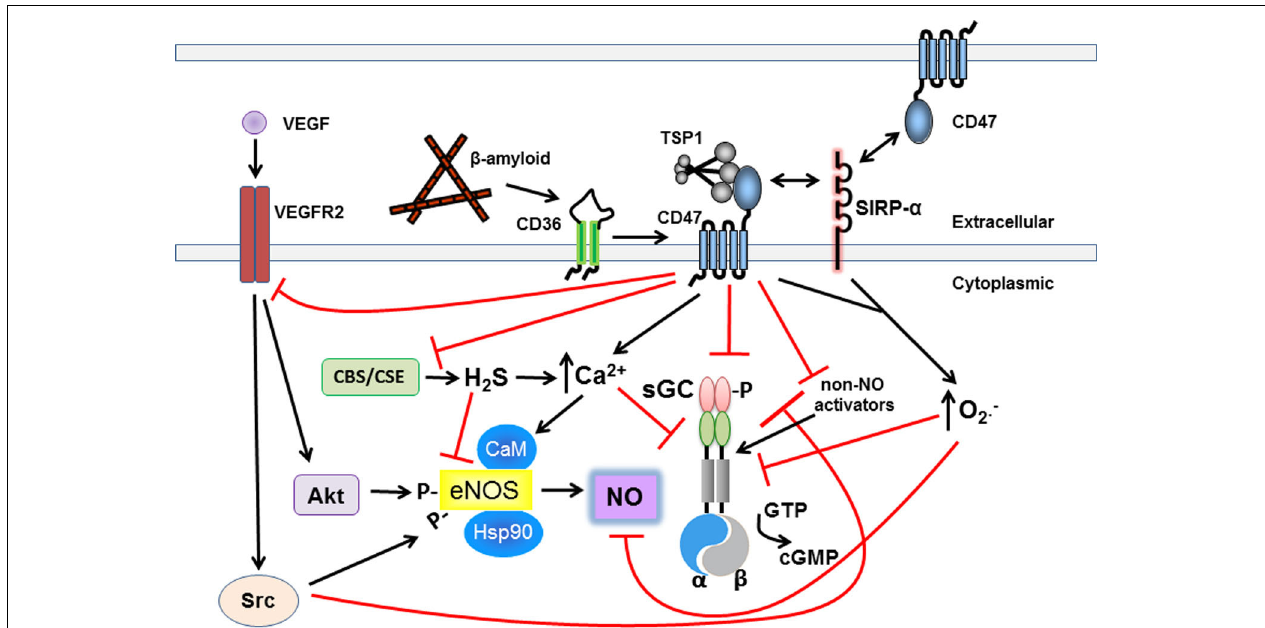
FIGURE 1 | Matricellular TSP1 via CD47 restricts NO-sGC-cGMP signaling. TSP1 inhibits the sGC-cGMP axis via multiple mechanisms